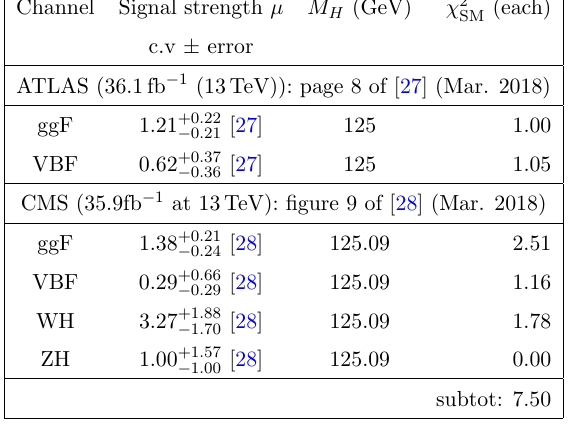
Table 11 . (LHC: 13 TeV) The same as table 9 but for H ! W + W (cid:0) .